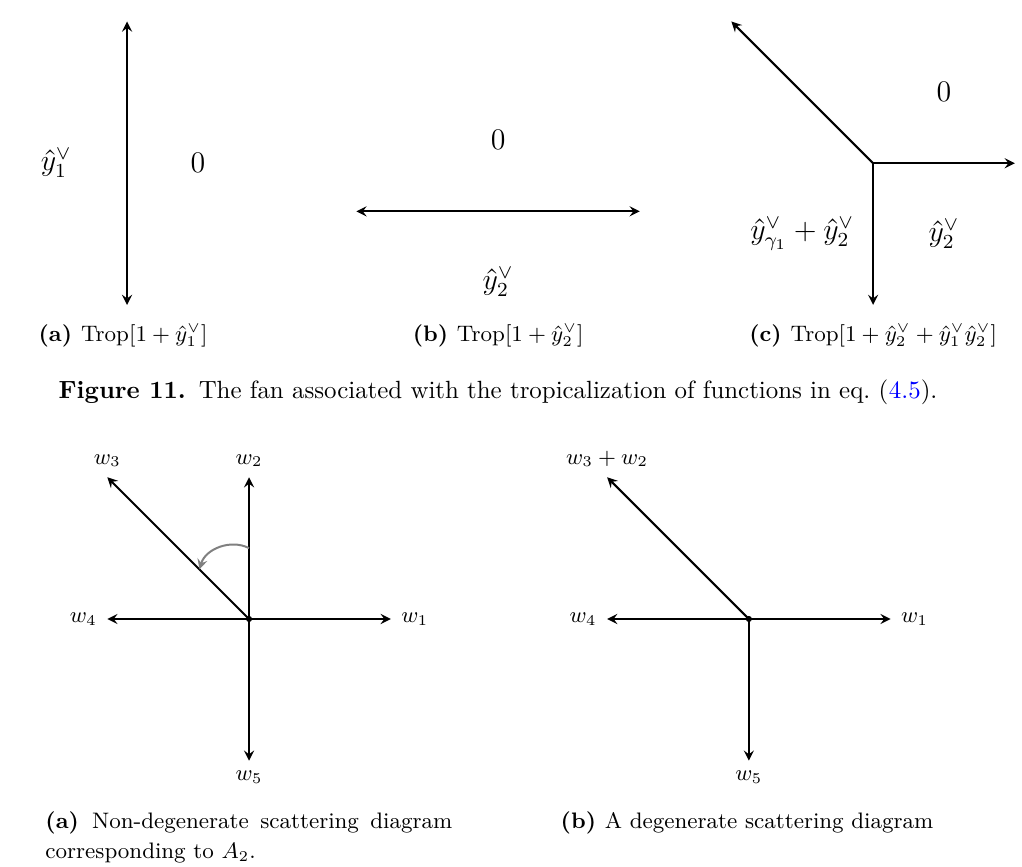
Figure 12. A demonstration of how to derive a degenerate scattering diagram from the non- degenerate scattering diagram for the A